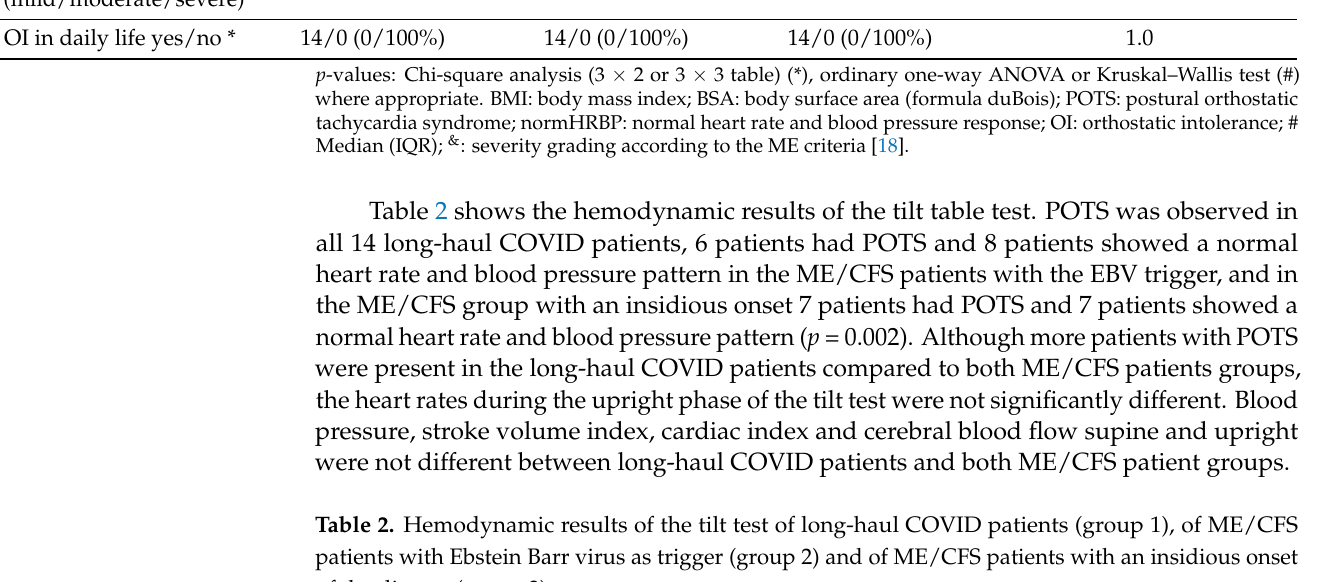
Table 2. Hemodynamic results of the tilt test of long-haul COVID patients (group 1), of ME/CFS patients with Ebstein Barr virus as trigger (group 2) and of ME/CFS patients with an insidious onset of the disease (group 3).